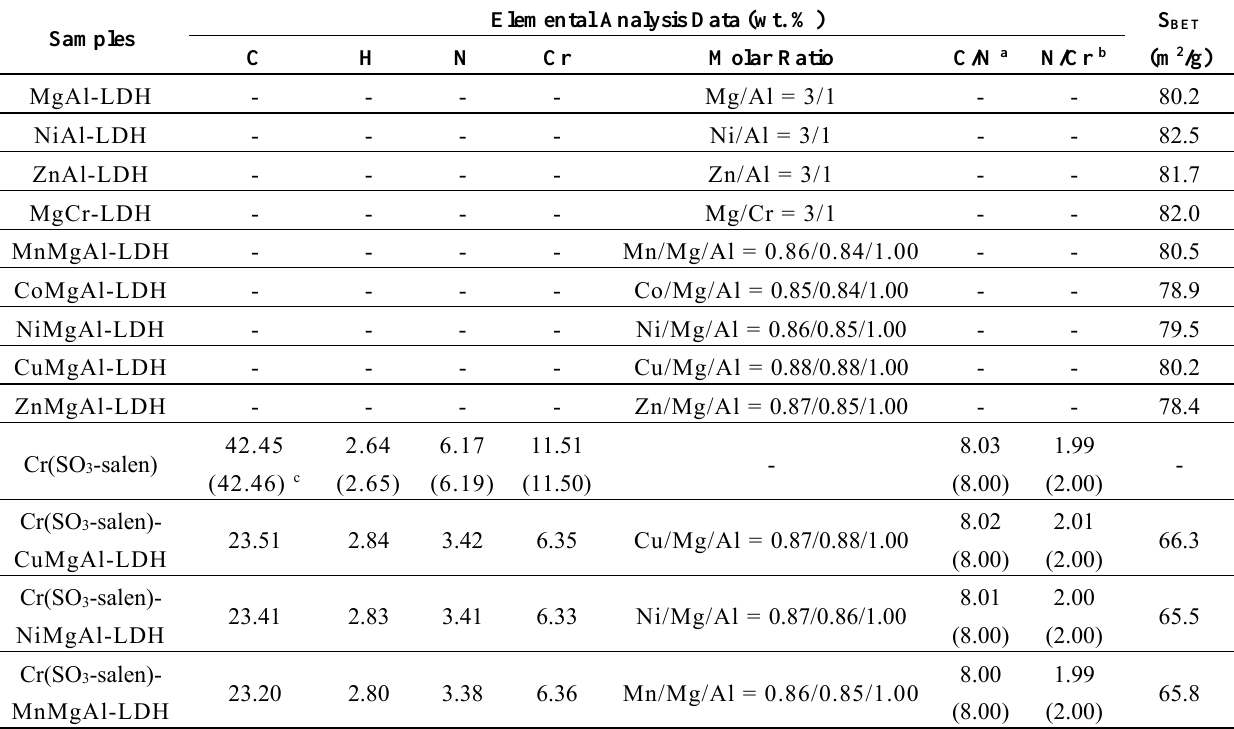
Table 1. Components and textural parameters of samples.